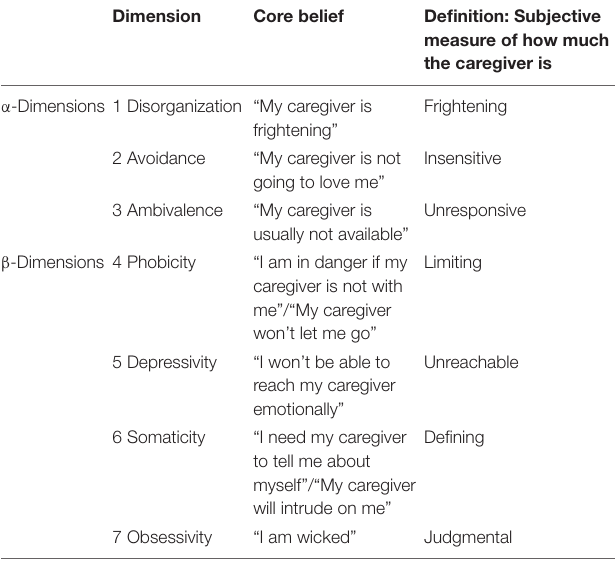
TABLE 3 | Attachment dimensions as core beliefs.